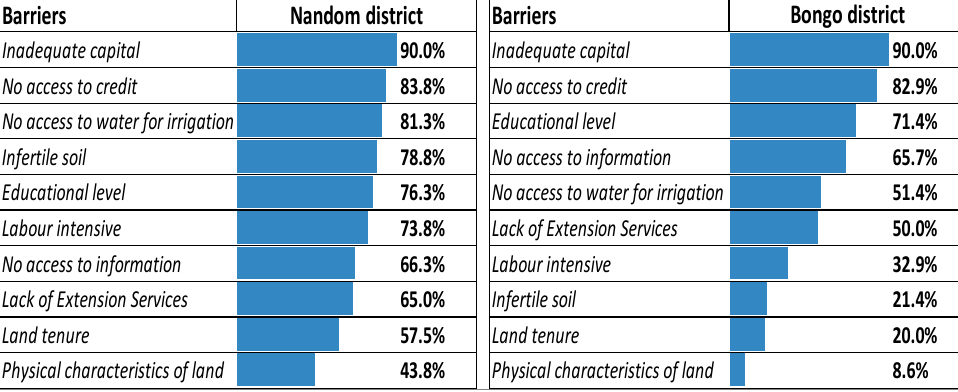
Figure 4. Barriers to the adoption of CSA practices in the districts.